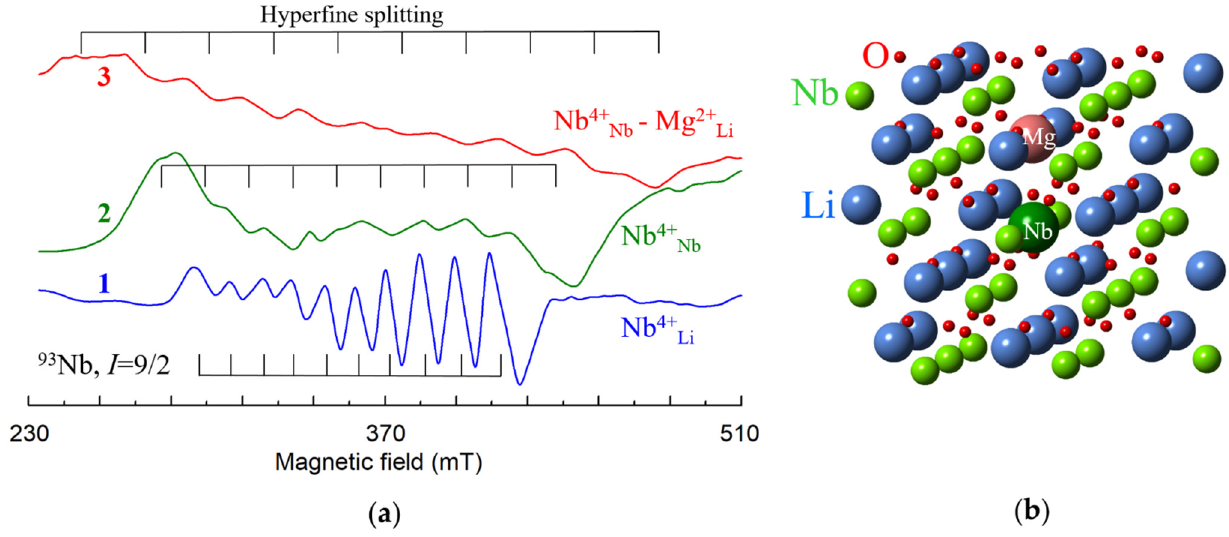
Figure 24. ( a ) E PR spectra of Nb 4+ centers in cLN (1) and cLN doped with 6 mol.% Mg (2) and 10 mol.% Mg (3), X band. ( b ) Model for axial Nb 4+Nb – Mg 2+Li center.